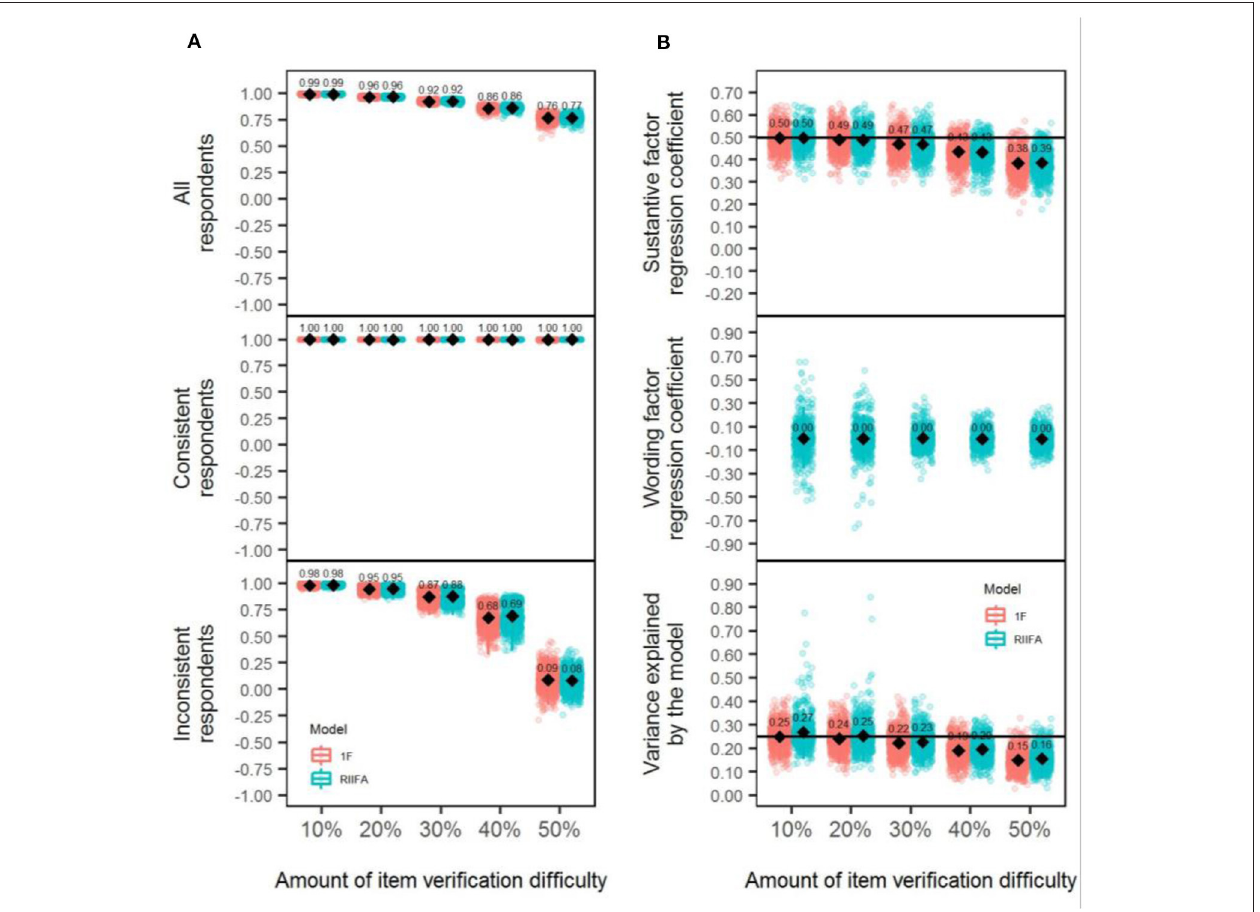
FIGURE 6 | Recovery of substantive factor scores and estimation of structural validity with the 1F model and the RIIFA model in the presence of item verification difficulty. In (A) , represented values are Pearson correlations, and results of the recovery of uncontaminated scores are presented for all the respondents, separately for consistent respondents, and separately for inconsistent respondents. 1F, unidimensional model with one substantive factor; RIIFA, random intercept item factor analysis model with one substantive factor and one wording method factor. In (B) , the horizontal black lines represent the substantive factor regression coefficient and the variance explained by the model with 0% of wording